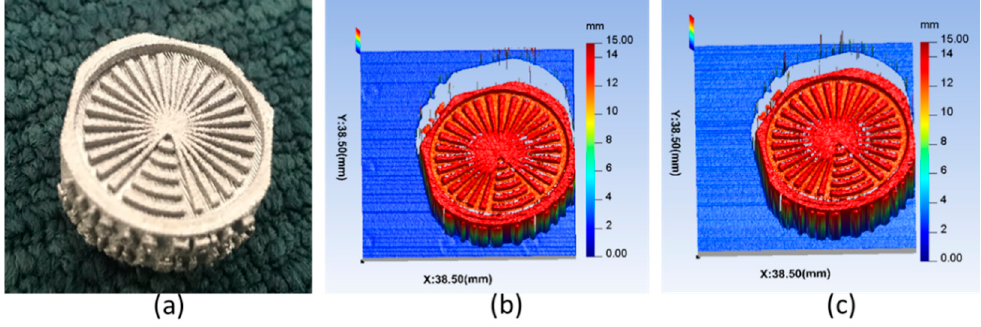
Figure 14. Printed metal sample and 3D reconstruction results: ( a ) photograph of tested printed sample; ( b ) areal map of tested printed sample before corrections; and ( c ) areal map of tested printed sample after corrections.